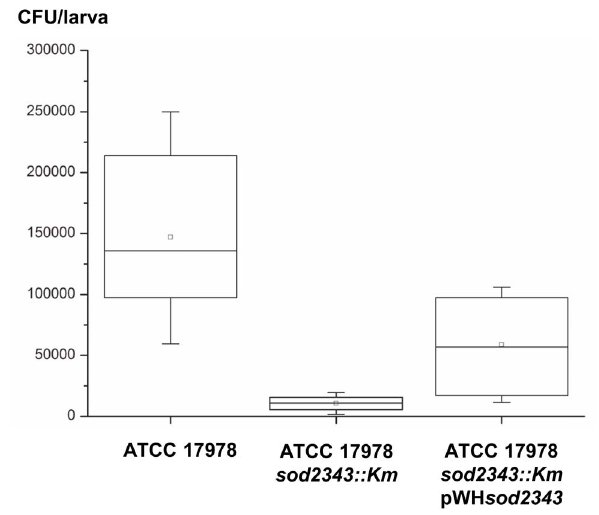
Figure. 6. Recovery of A. baumannii sod2343 mutant from Galleriamellonella larvae is minor compared to parental strain. Groups of 10 larvae were injected with 1.5 6 10 6 CFU of ATCC 17978, ATCC 17978 sod2343::Km , and ATCC 17978 sod2343::Km pWH sod2343 , respectively. Directly after injection of the 10 larvae within a group, the larvae were frozen at 2 80 u C, homogenized and serial dilutions were plated on CHROMagar Acinetobacter to determine CFUs. Boxes indicate the 25–75% region, the median is indicated by a line in the box, the average is indicated by a small square, whiskers indicate maximum and minimum values,